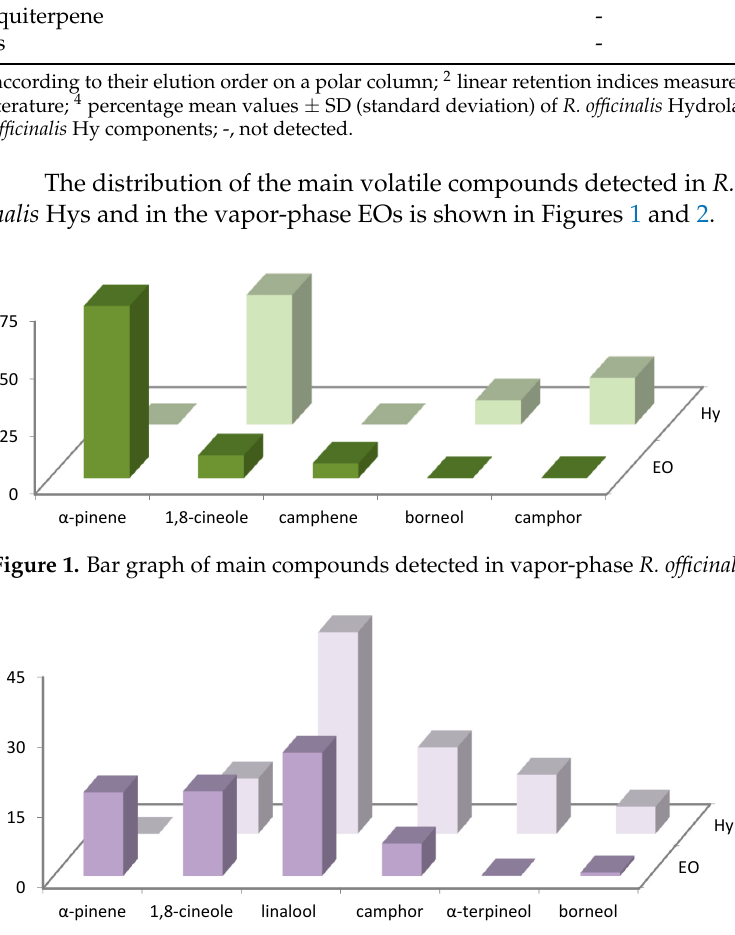
Figure 2. Bar graph of main compounds detected in vapor-phase L. angustifolia Hy and EO.